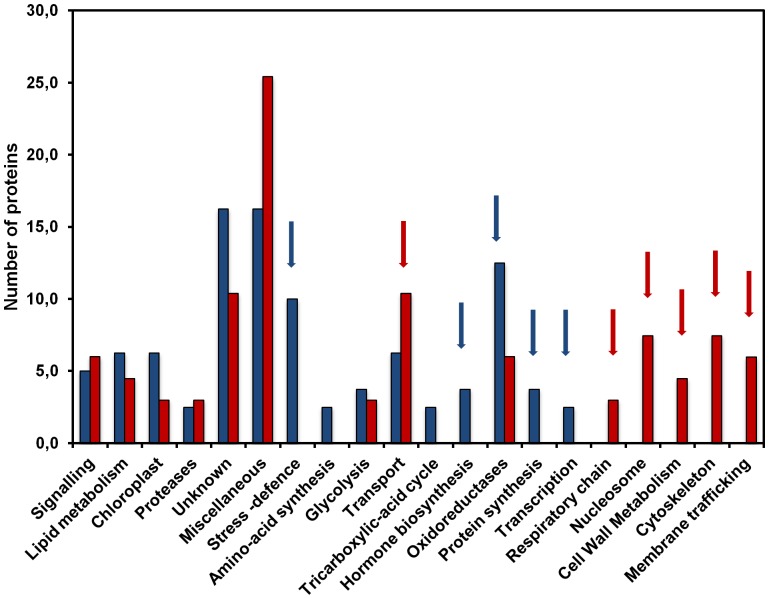
Comparative distribution of under and over-represented proteins according to functional categories.Black bars = over-represented, Grey bars = under-represented.